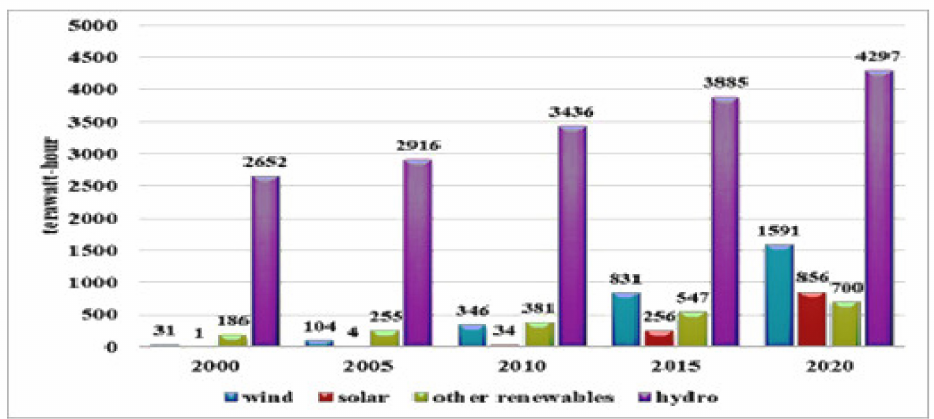
Figure 2. Global renewable energy scenario